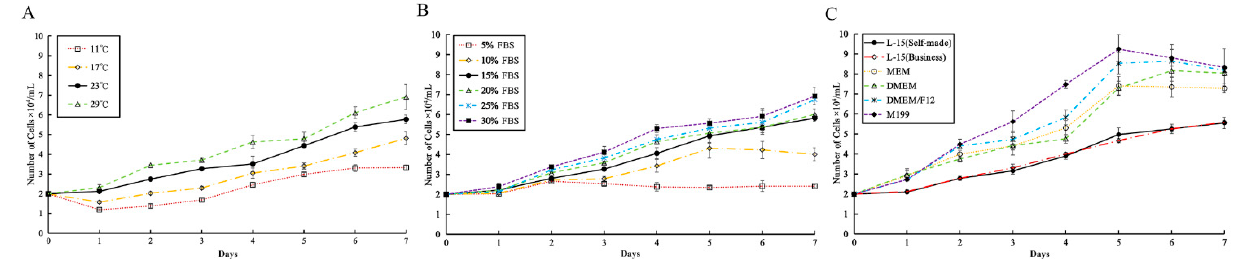
Figure 3. Growth kinetics of JFSP cell line at passage 55. ( A ) Effect of temperature on cell growth in